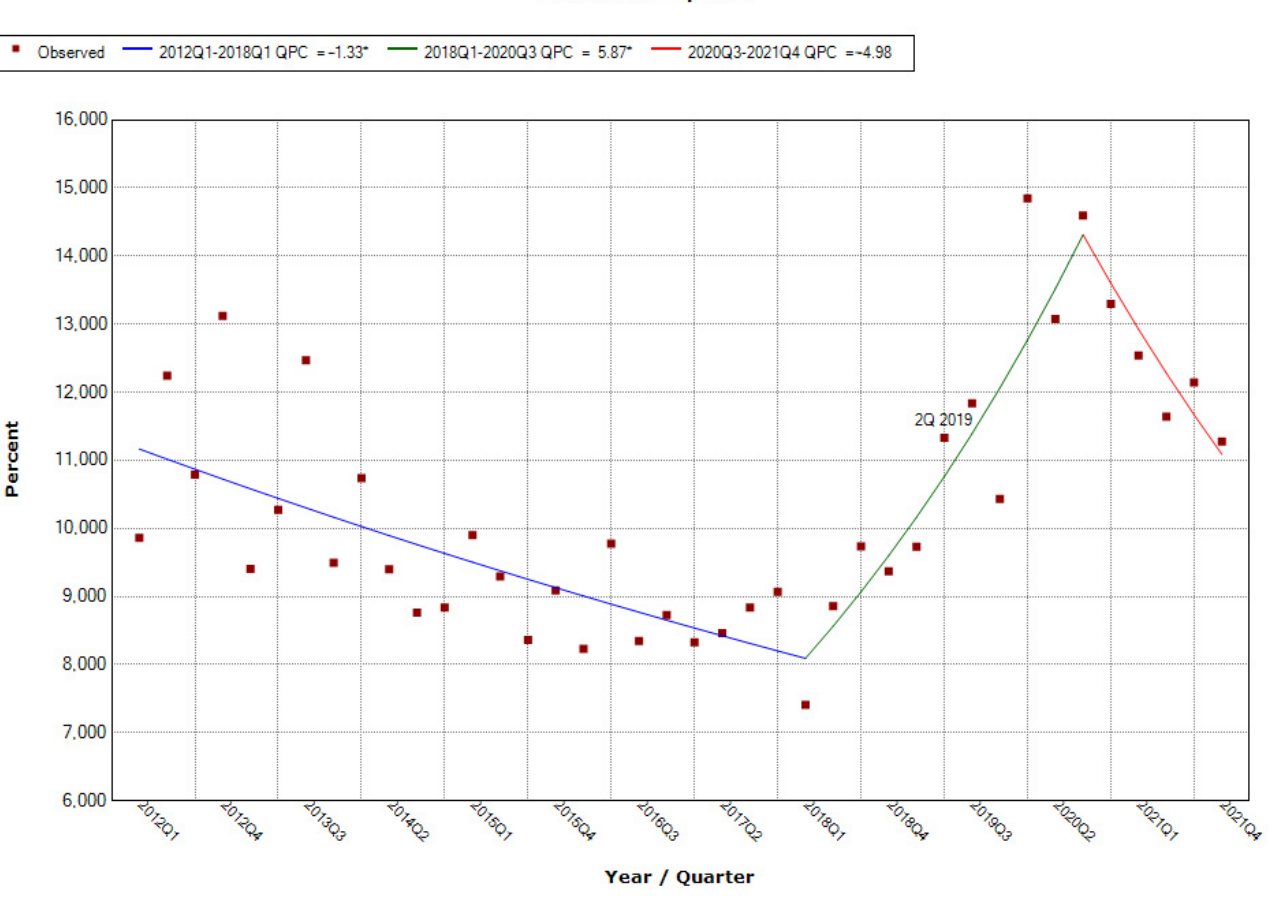
Figure A32. Percentage of products containing zinc in individual quarters in the period from 2012 to 28 November 2021. Joinpoints mark trend turning points. The date above the observation indicates the moment of publication of the scientific opinion/resolution.